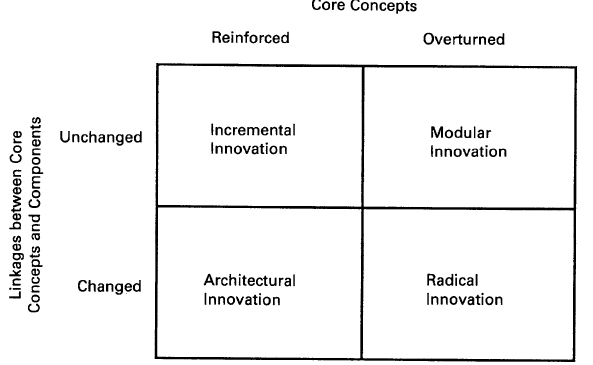
Figure 2. Innovation quadrant (reference: Henderson and